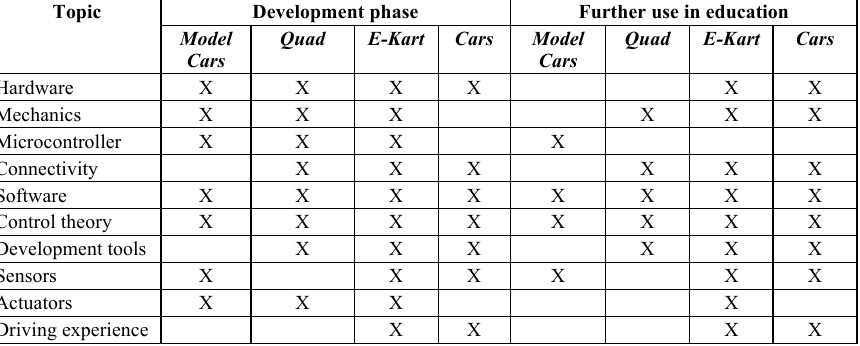
Table 1. Important technical topics of vehicle electronics and main correlations to rolling labs